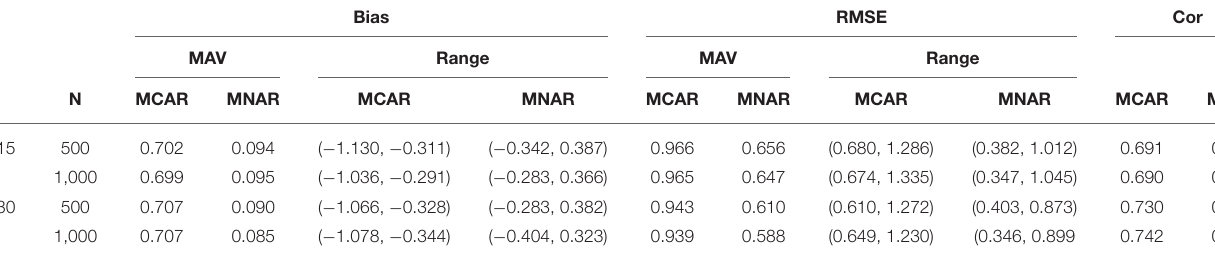
TABLE 2 | Summary of the general ability for high missingness conditions.